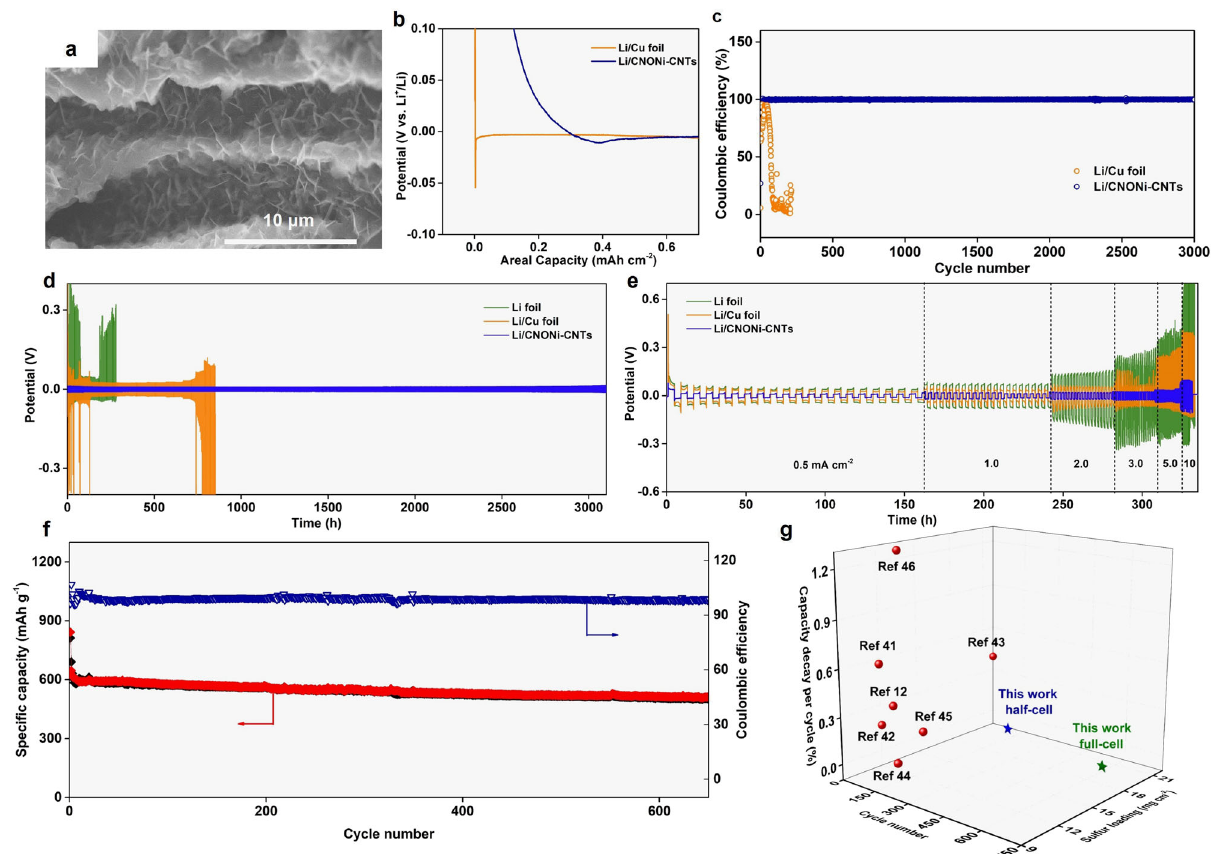
Fig. 5 Plating/stripping behavior of lithium anode and electrochemical performance of lithium − sulfur full batteries. a SEM image of the 400 μ m WLC- CNTs electrode with the amount of Li plating for 10 mAh cm − 2 at 1 mA cm − 2 . b Nucleation behavior of Li metal on different hosts at a current density of 0.05 mA cm − 2 . c Comparison of the Coulombic ef fi ciency of Li plating/stripping on the WLC-CNTs electrode and a planar Cu electrode with current density of 1 mA cm − 2 at a fi xed areal capacity of 1 mAh cm − 2 . d Galvanostatic plating/stripping pro fi les in Li foil, Li/Cu foil, and Li/WLC-CNTs symmetric cells at 1 mA cm − 2 with areal capacity fi xed at 2 mAh cm − 2 . e Rate performance of the symmetric cells with a fi xed capacity of 2 mAh cm − 2 . f